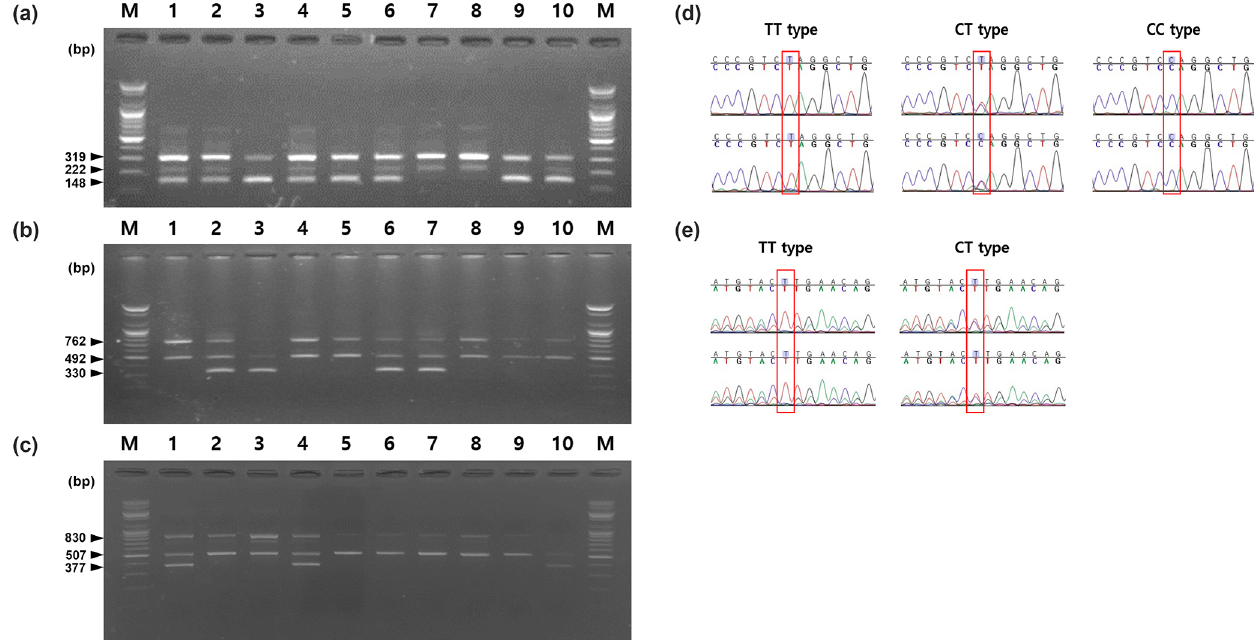
Figure 2. Results of electrophoresis for each genotype amplified using three SNPs. M : molecular weight marker. (a) HSPB1 g.2352T > C SNP, CC type was amplified to 222 and 319bp, CT type was amplified to 148, 222, and 319bp, TT type was amplified to 148 and 319bp; (b) ADH1C c.-64T > C SNP, TT type was amplified 492, 762bp, CT type was amplified 330, 492, 762bp; (c) FASN g.17924G > A SNP, GG type was amplified 507, 830bp, AG type was amplified 377, 507, 830bp; (d) result of direct sequencing for the HSPB1 g.2352T > C SNP; (e) result of direct sequencing for the ADH1C c.-64T > C SNP. Table 1. Information, sequences, and concentrations of primers for SNPs used in this study. Gene SNP Primer name Primer sequence (5–3 (cid:48) ) Concentration of primer (dbSNP no.) in AS-PCR (uM) HSPB1-OF GCACGGCTACATTTCCCGTTGCTTCAC 1.2 g.2352T > C HSPB1-OR 1.2 HSPB1 0.6 0.6